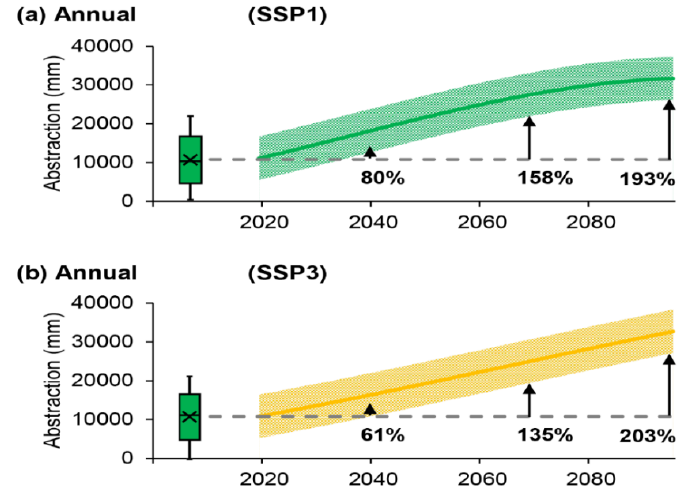
Figure 6. Annual projections of groundwater abstraction in the urban area of Lahore, under ( a ) SSP1, and ( b ) SSP3 population scenarios for the 21st century. The shaded area in annual graphs represents the 25th and 75th percentile, and smooth lines are twenty years moving averages. Change in ab- straction will be significant at p = 0.05.